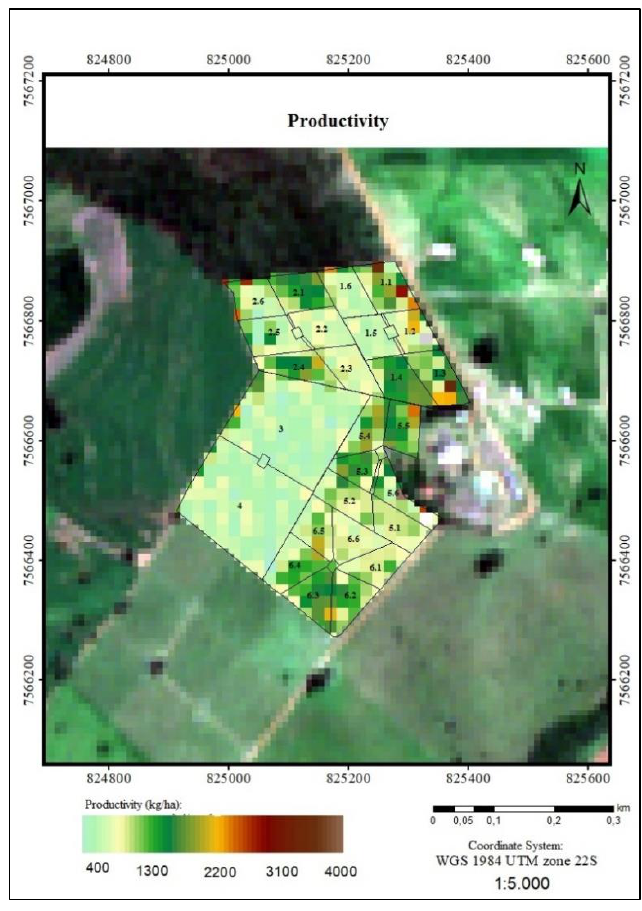
Figure 15. Productivity map (kg ha −1 ) with 20 m spatial resolution, estimated with Equation 2 applied on the Sentinel-2 image of April 25, 2018, over Piatã and Decumbens grassland area.